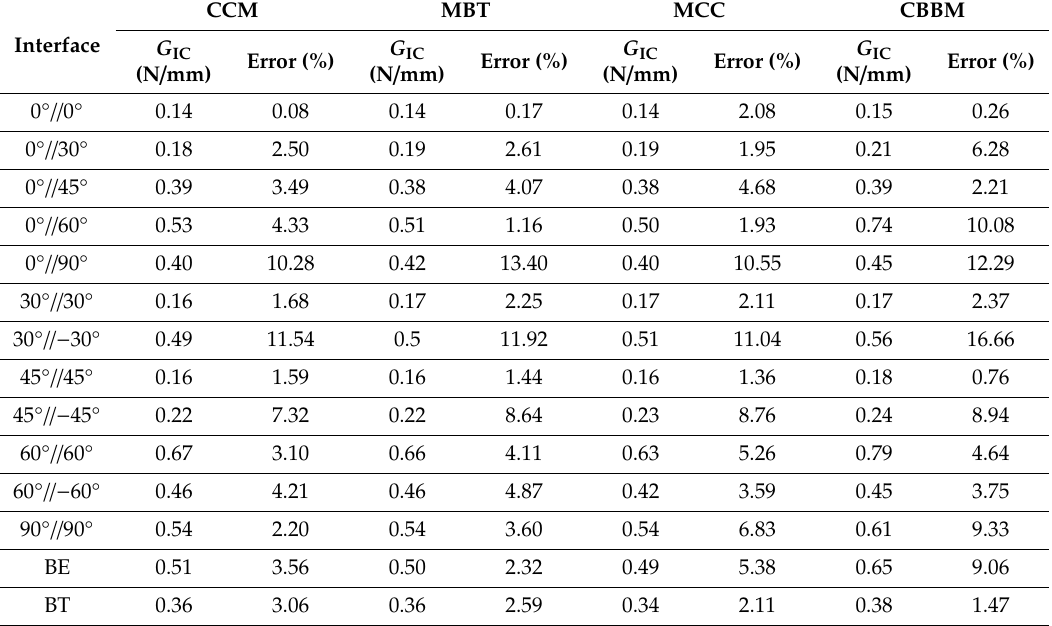
Table 5. Critical strain energy release rate (c-SERR) obtained for different DCB specimens by using different calculation methods (average values and standard deviations).